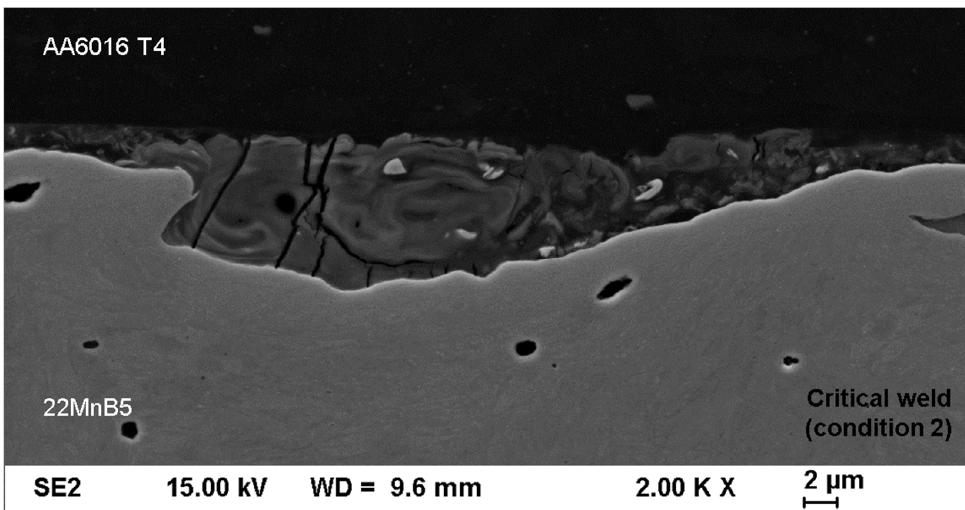
Figure 10. SEM image (SE mode) of the transition zone of a critical weld (welding parameters according to condition 2) with numerous cracks.